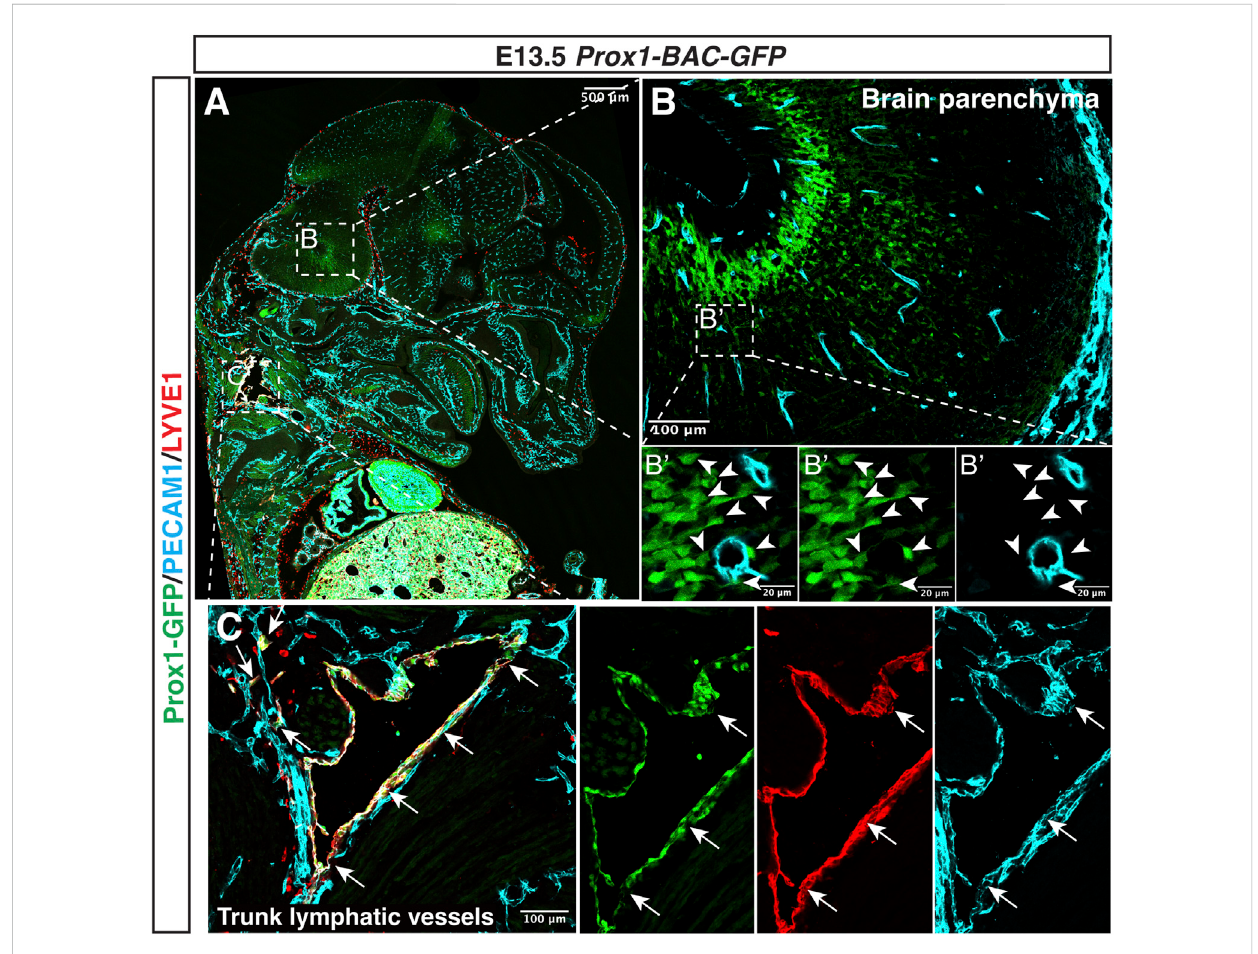
FIGURE 5 Prox1 is not expressed in the developing CNS vasculature. Section immunostaining of Prox1-BAC-GFP brain at E13.5 with anti-PECAM1 (cyan) and anti-LYVE-1 (red) is shown. The boxed regions in (A) are magni fi edin (B,C) , and theboxed region in (B) is magni fi edin (B ’ ) . In thebrain parenchyma (B,B ’ ) , Prox1-GFP expression is found in a subset of neural progenitors [ (B) green, white arrowheads], but this GFP expression does not colocalize with the PECAM1+endothelialcells[ (B ’ ) greenvs.cyan].Inthetrunk (C) ,Prox1-GFP+LYVE-1+PECAM1+ lymphaticvesselsarefound[ (C) arrows].Scalebars 500, 100, and 20 μ